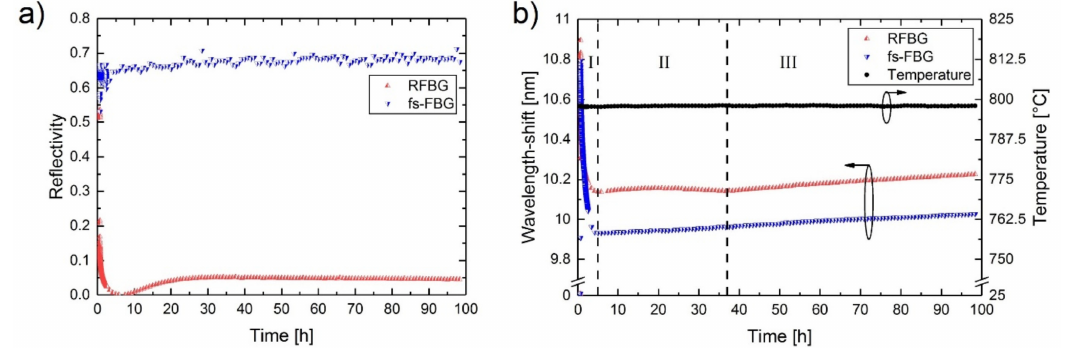
Figure 4. Simultaneous annealing study of a PbP FBG and a RFBG at 800 ◦ C. ( a ) reflectivity and ( b ) Bragg wavelength drift (reproduced from